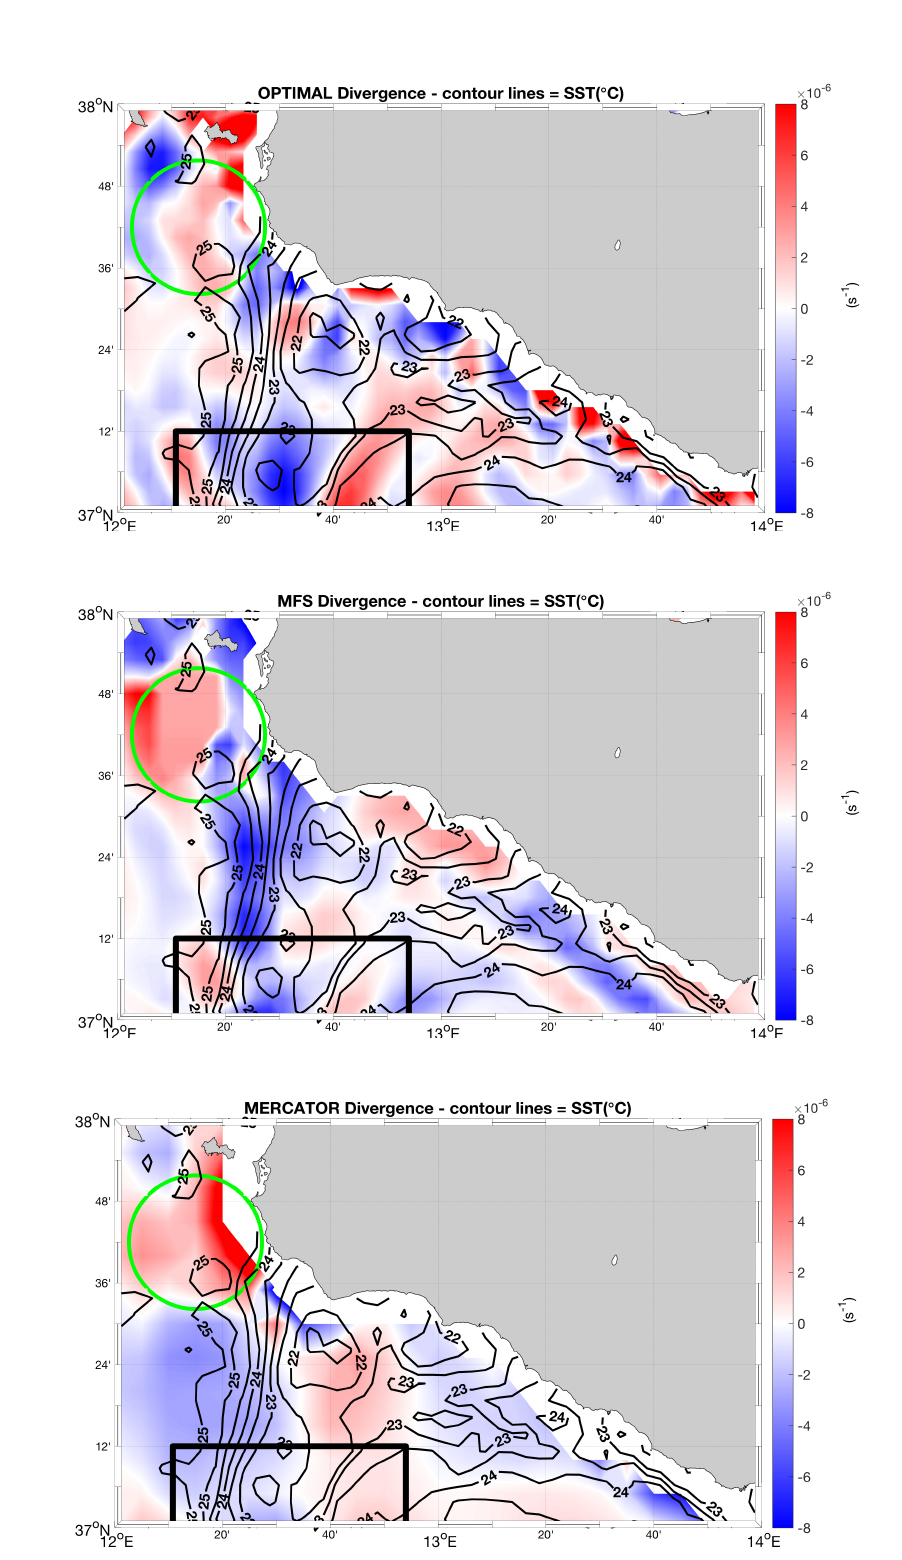
Figure 6. Divergence of the surface currents field in the Sicily Channel (23 July 2016). Top panel: Optimal currents; middle panel: MFS operational model for the Sicily Channel; bottom panel: MERCATOR operational model. Black contours indicate sea surface temperature, in ◦ C. The light green and dark green circles are referenced in Section